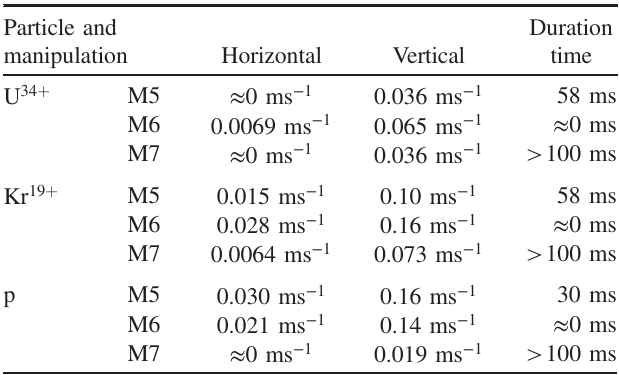
TABLE VIII. The growth rates of the transverse unbunched beam instability.